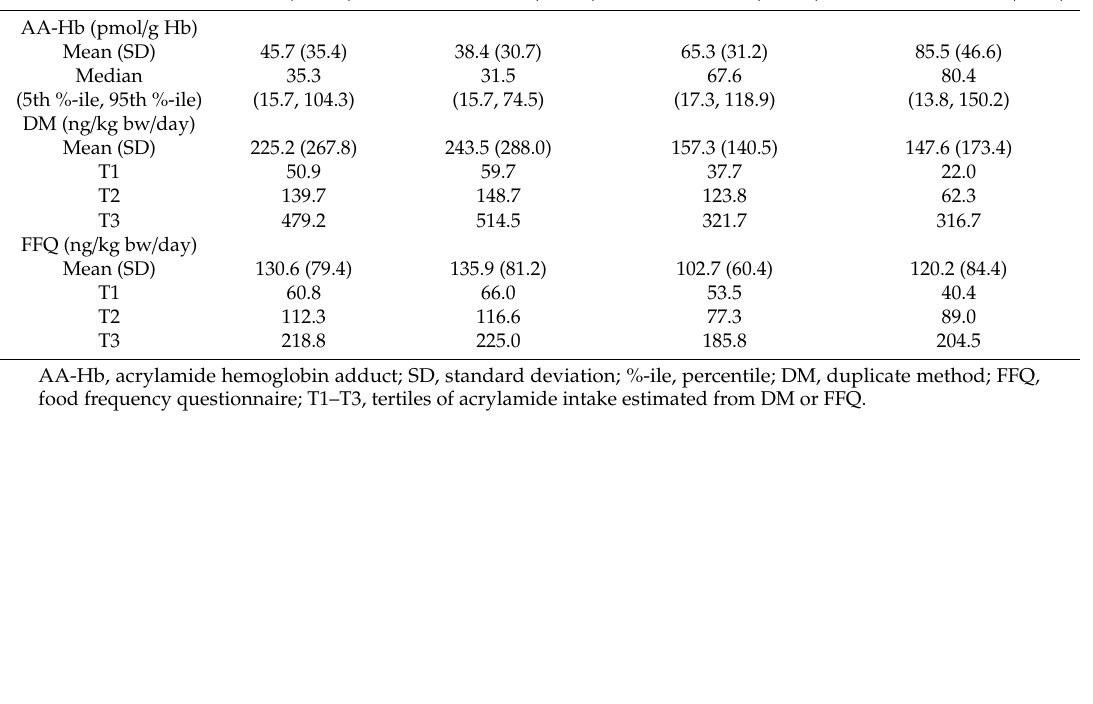
Table 2. Comparison of acrylamide exposure level from AA-Hb, DM, and FFQ.